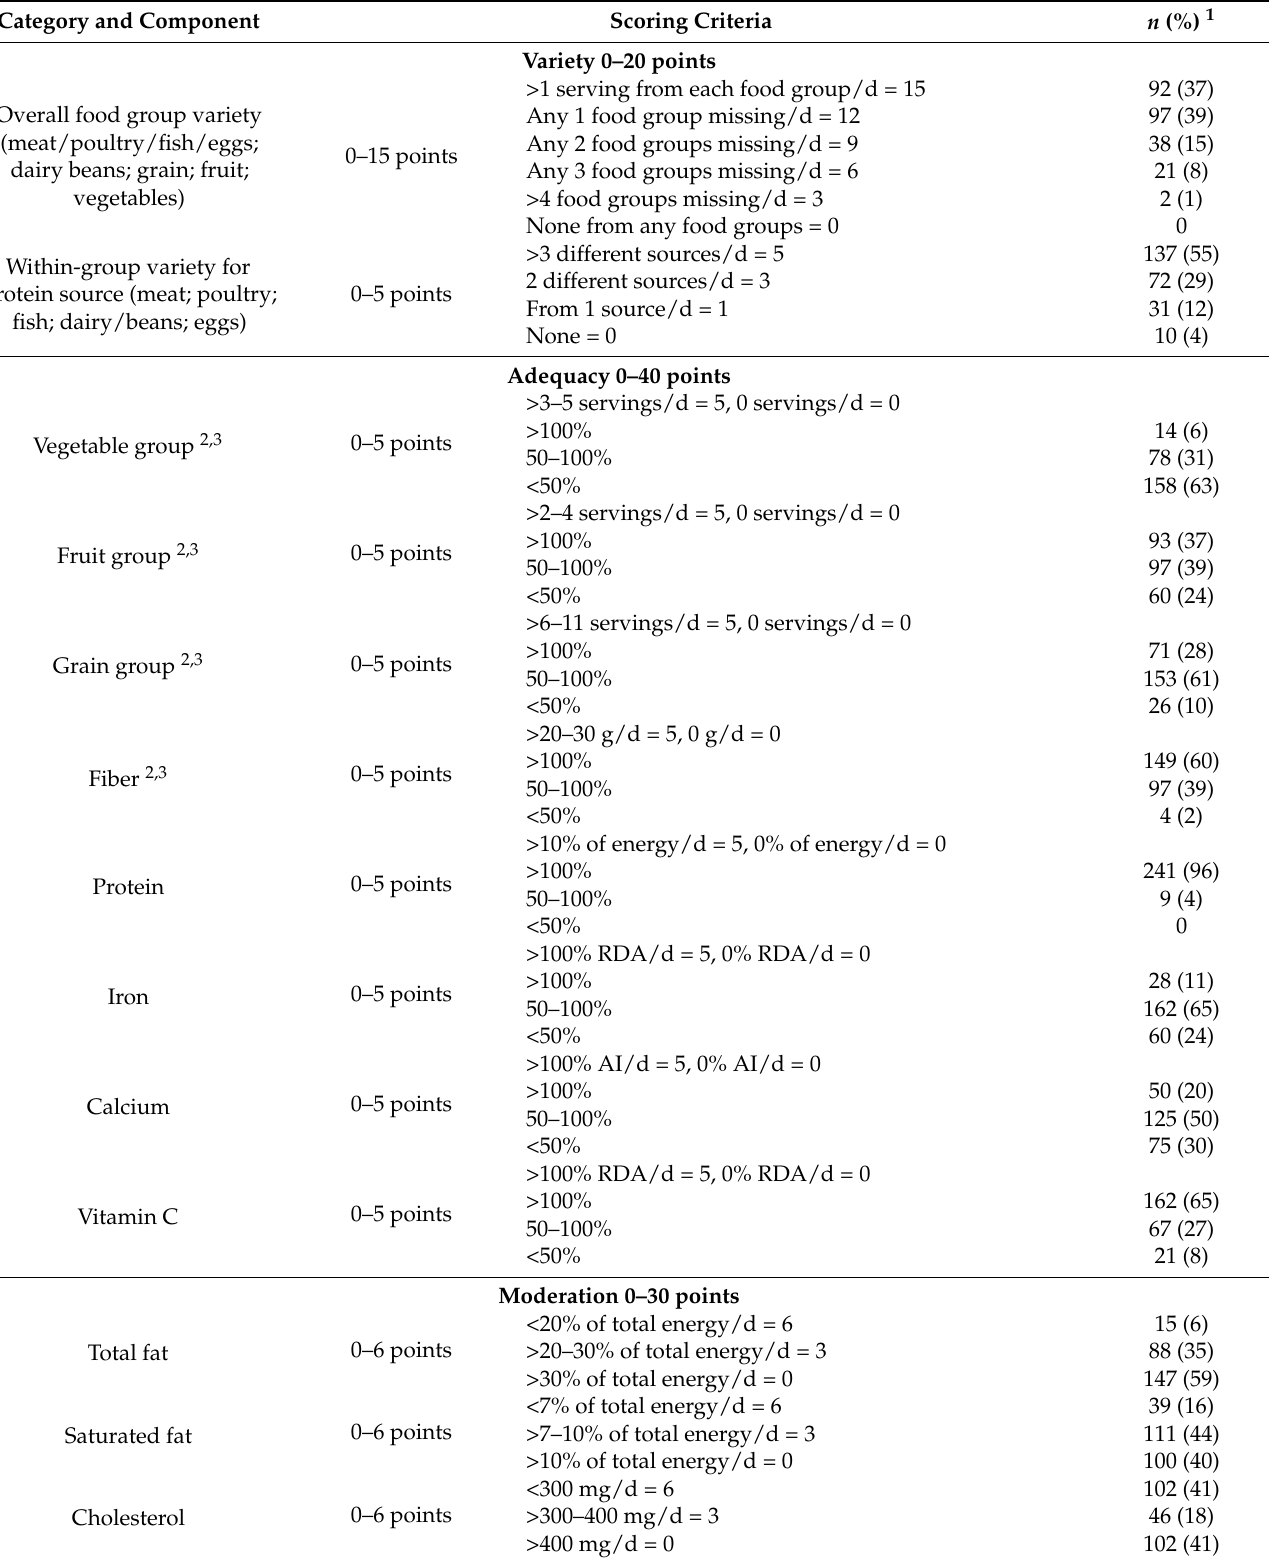
Table 1. Participant scores according to the Diet Quality Index-International (DQI-I) scoring criteria ( n = 250) [35]. Category and